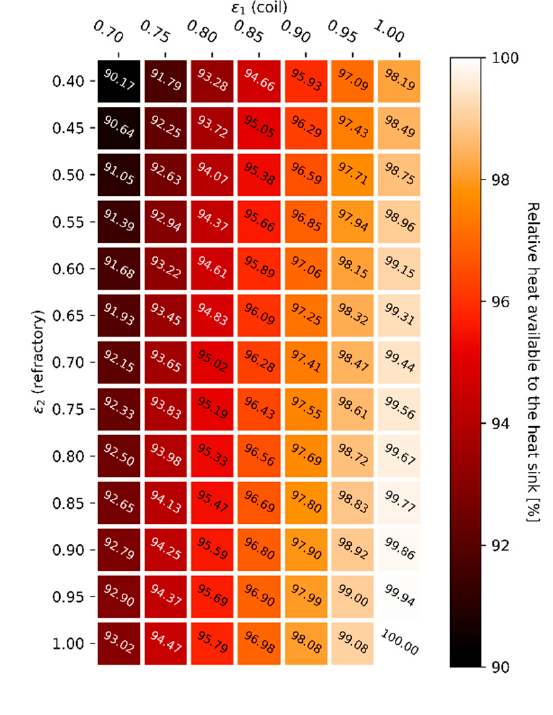
Figure 13. Relative heat available to the heat sink for a constant radiative heat flux in the presence of a gray-plus-clear gas.